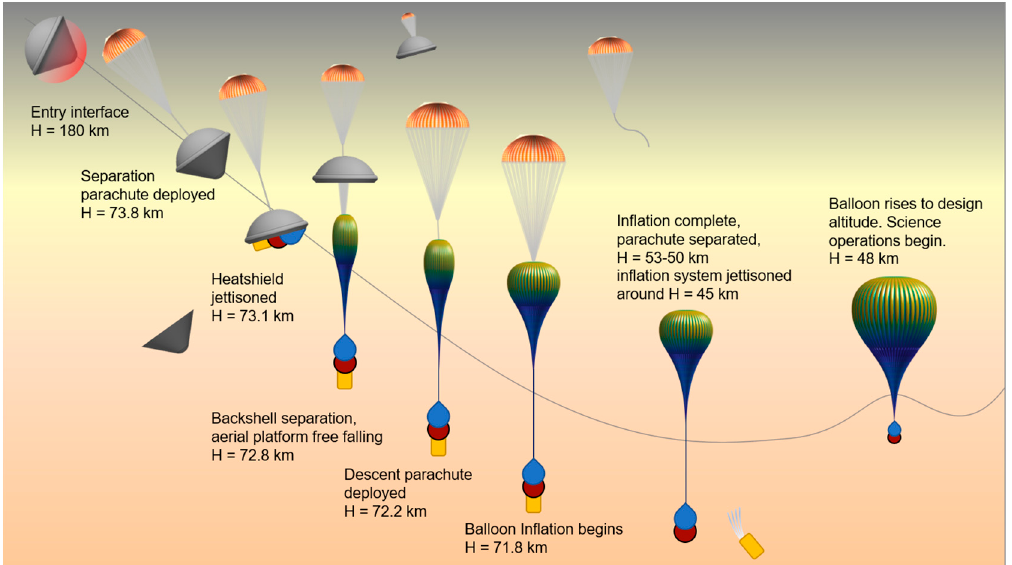
Figure 4. Entry, Descent, and Inflation concept of operations. The EDI conops is derived from the VeGa balloon EDI conops [21]. Table 2. Timeline of the entry, descent, and inflation operations.